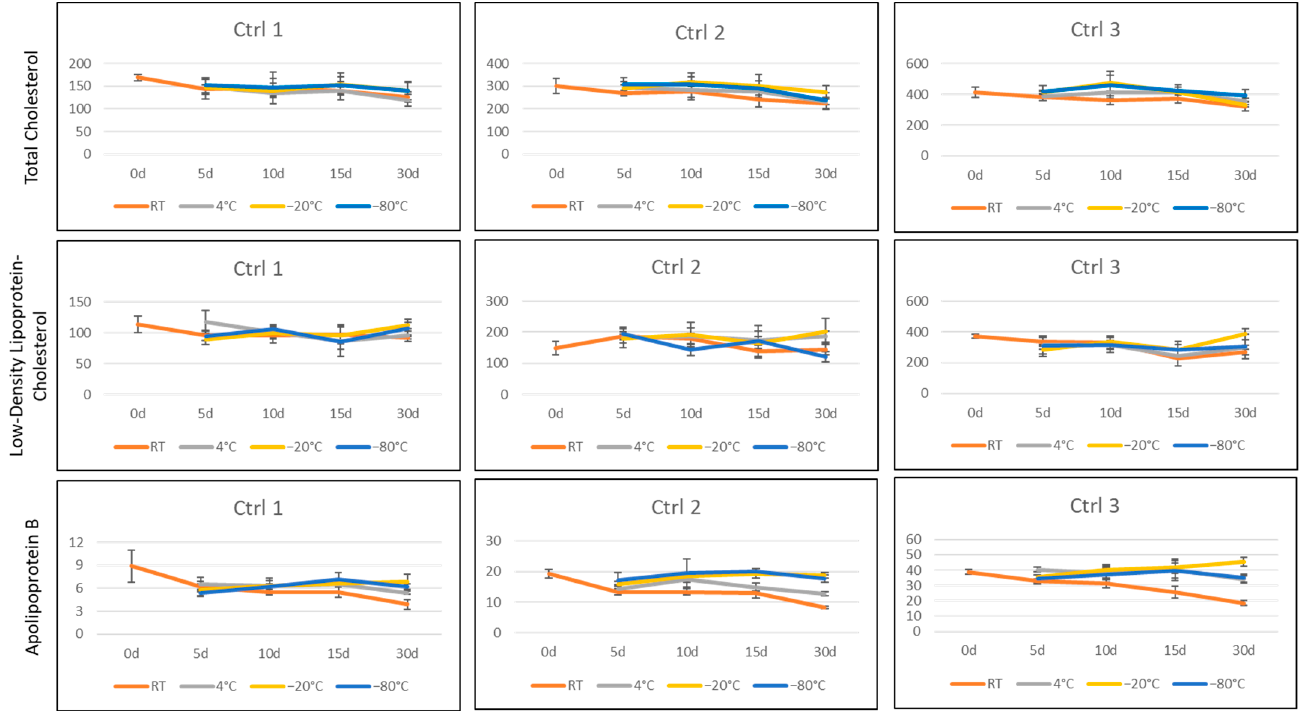
Figure 1. Stability studies. At each time point (0, 5, 10, 15, and 30 days), the three controls (Ctrl 1, 2, and 3) stored at four different temperatures (RT, 4, − 20, and − 80 ◦ C) were evaluated in 5 replicates. Error bars represent standard deviation among the five replicates.